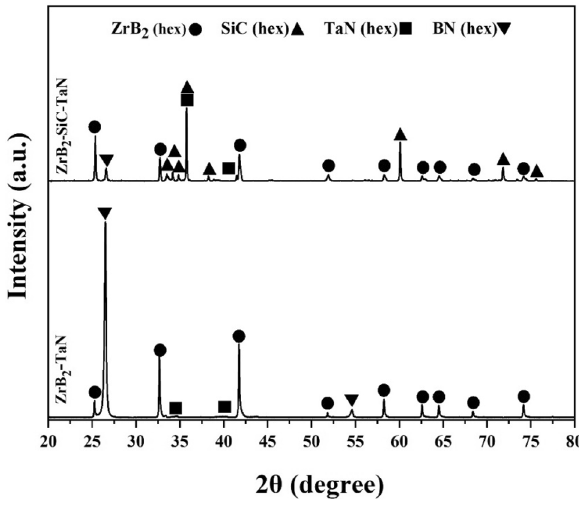
Figure 1. XRD patterns of ZrB 2 -TaN and ZrB 2 -SiC-TaN